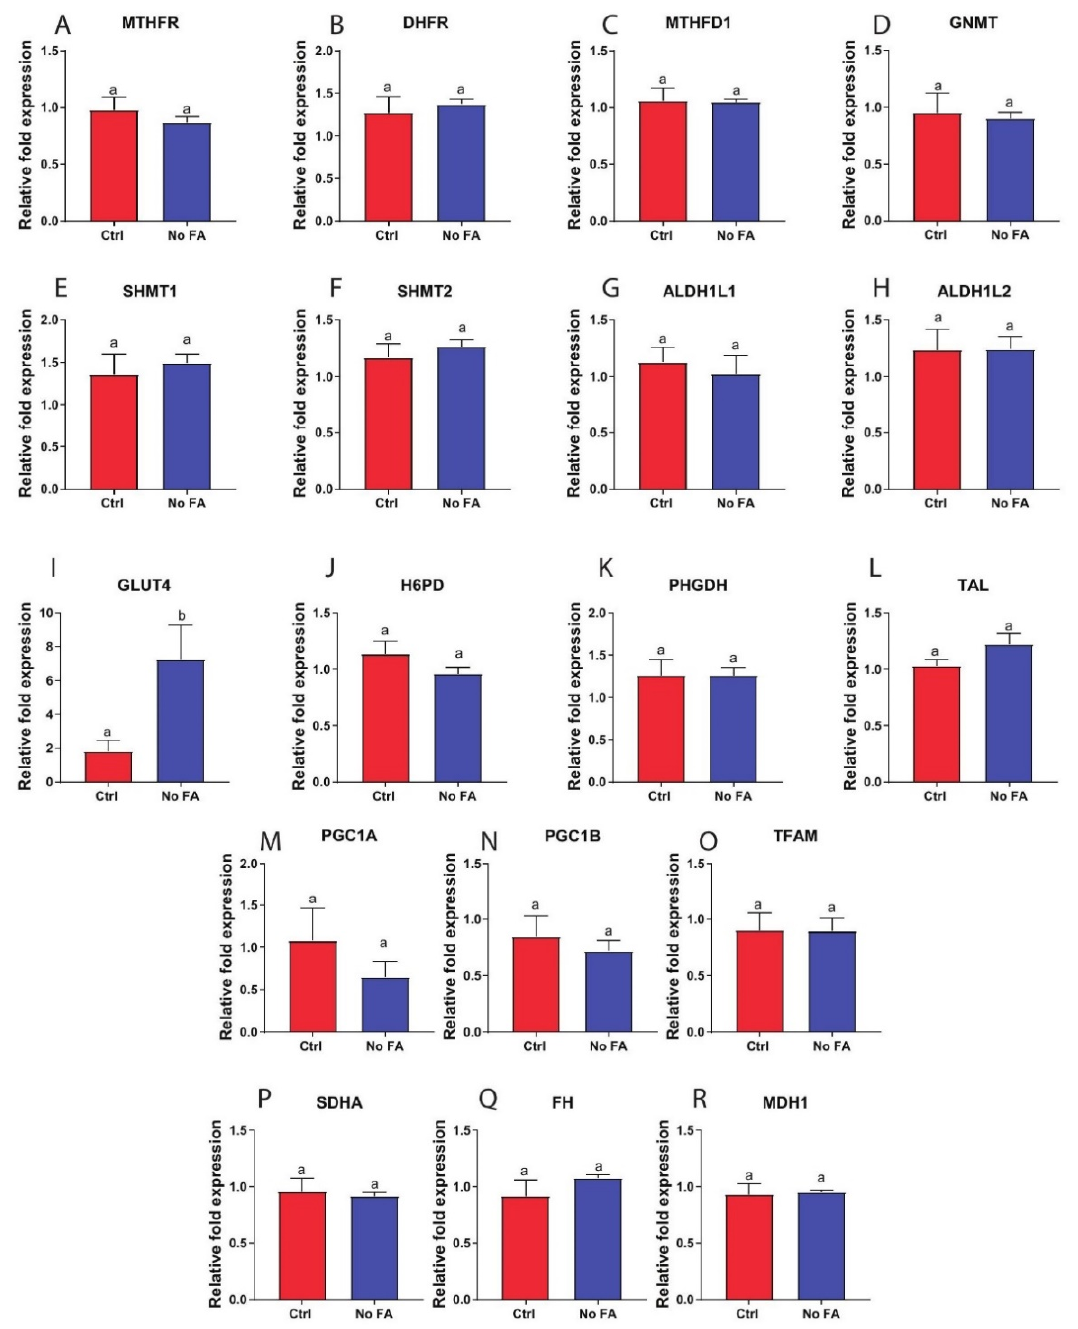
Figure 8. M-Wnt tumor response to FA withdrawal. M-Wnt tumor expression of MTHFR ( A ), DHFR ( B ), MTHFD1 ( C ), GNMT ( D ), SHMT1 ( E ), SHMT2 ( F ), ALDH1L1 ( G ), ALDH1L2 ( H ), GLUT4 ( I ), H6PD ( J ), PHGDH ( K ), TAL ( L ), PGC1A ( M ), PGC1B ( N ), TFAM ( O ), SDHA ( P ), FH ( Q ), and MDH1 ( R ) determined by qPCR (n = 5/group). Student’s t-test was used to determine statistical significance between groups ( p < 0.05), different letters indicate significant differences.